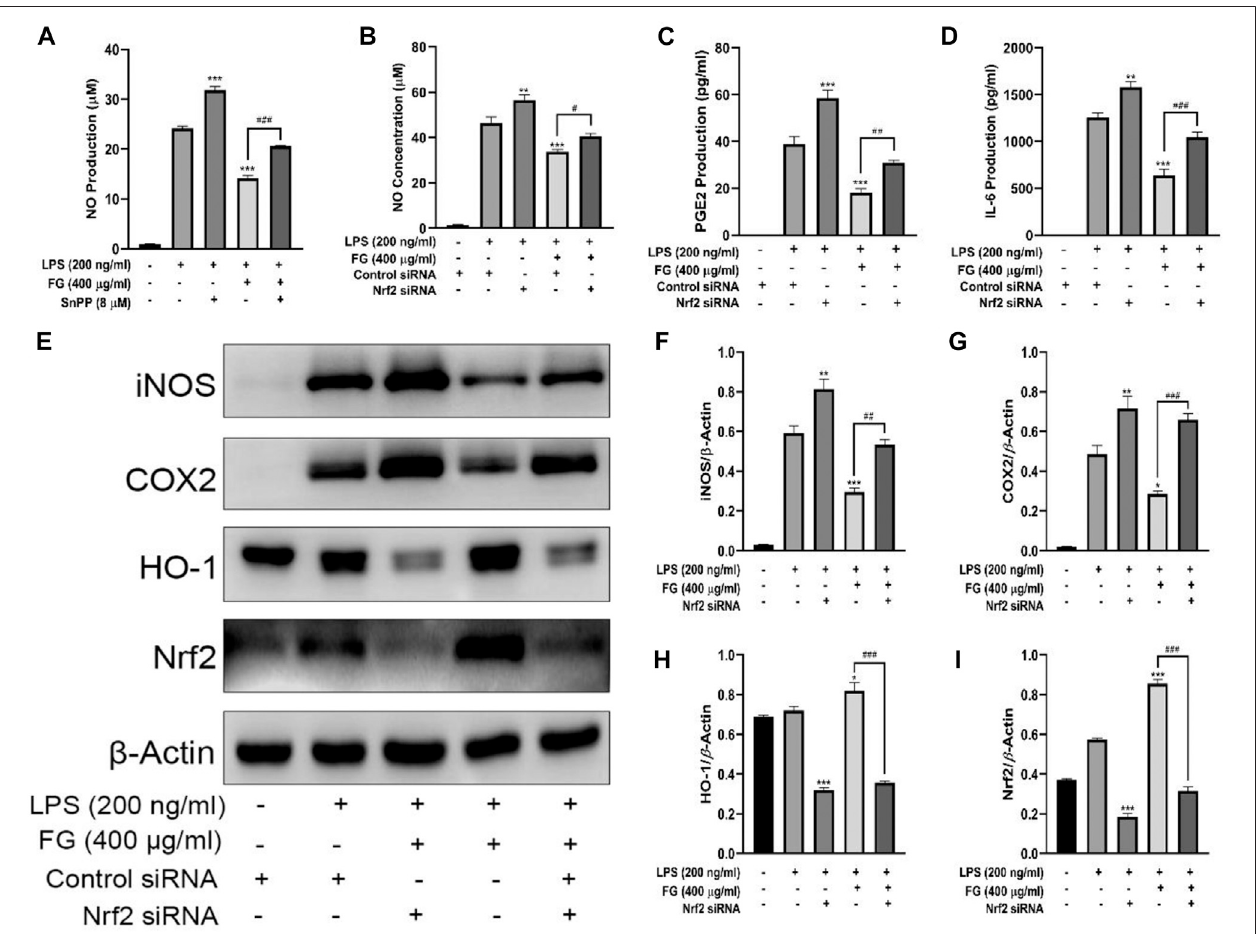
FIGURE9| Effects ofFG ontheNrf2/HO-1signaling pathway inLPS-inducedBV2microglia. BV2cellswerepretreated withSnPP (20 µM) for1 h, followed bythe treatment with FG extraction (400 μ g/ml) and LPS (200 ng/ml) for 24 h. The production of NO in the cell culture supernatant was evaluated using a Griess assay kit (A) . Then BV2 cells were transfected with Nrf2 siRNA or control siRNA to silence the Nrf2 gene, followed by the treatment of FG extraction (400 μ g/ml) and LPS (200 ng/ml) for another 24 h. The production of NO, PGE 2 , TNF- α , and IL-6 in the cell culture supernatant was measured using Griess assay kits or ELISA kits (B – D) . The expression of iNOS, COX2, Nrf2, and HO-1 was detected by Western blot (E – I) . Results are expressed as mean ± SEM of three independent experiments (* p < 0.05, ** p < 0.01, *** p < 0.001, # p > 0.05, ## p < 0.01, ### p < 0.001).